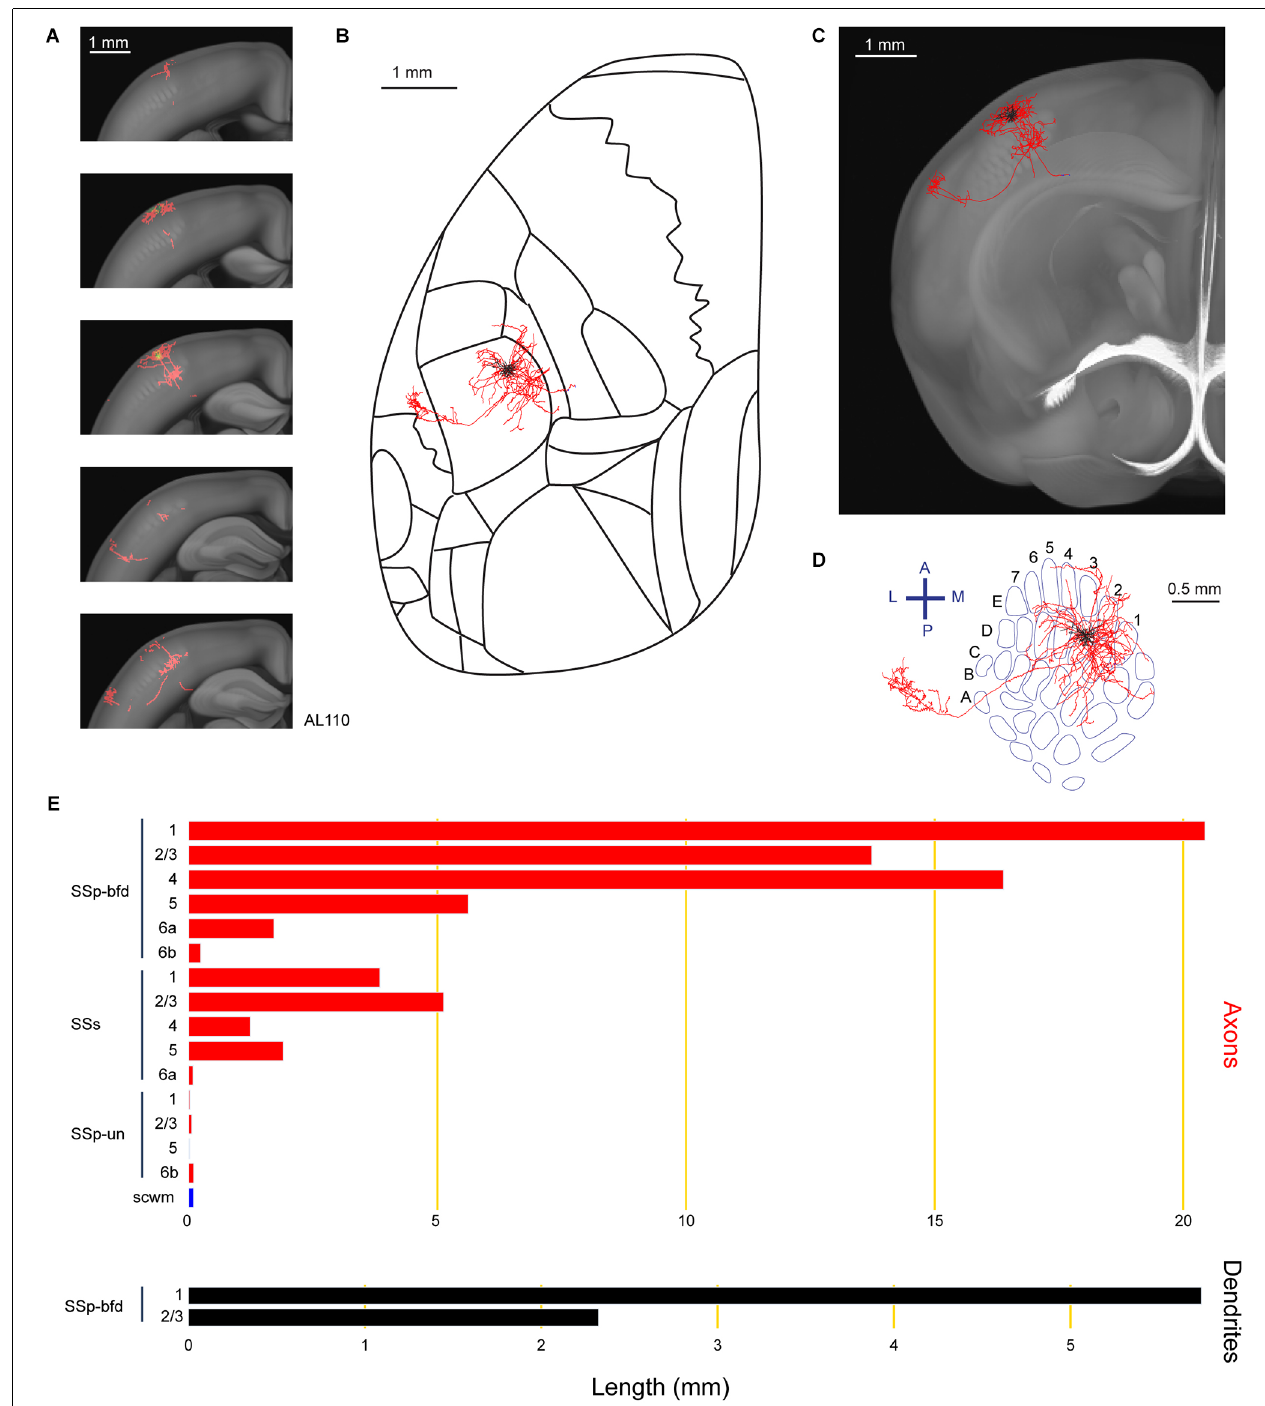
FIGURE 2 | Reconstruction and quantification of example neuron AL110 with projections to the supplementary somatosensory cortex. (A) Serial overlays of GFP-labeled axon (red) and dendrites (green) in coronal views encompassing the anterior-posterior span of the axons of 1.5 mm. Each section represents a maximum projection of 300 µ m. (B) Maximum projection of the reconstructed axon and dendrites in horizontal view, aligned to the Allen Mouse CCFv3 to indicate the boundaries between cortical regions. (C) Maximum projection of reconstructed axon and dendrites in coronal view overlaid with an anatomical section from the Allen Mouse CCFv3. (D) Maximum projection of reconstructed axon and dendrites in a tangential view (rotated 30 degrees) over the barrel field (blue). The cell is located in the D3 barrel column. (E) Quantification of axonal ( top ) and dendritic ( bottom ) length in respective brain regions identified by the Allen Mouse CCFv3. For (B) to (E) : dendrites are shown in black, axon in gray matter is shown in red, and axon in white matter is shown in blue.